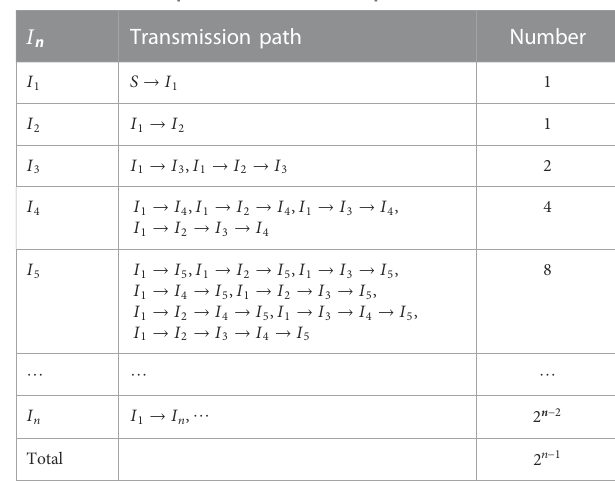
TABLE 1 Simulation parameter values for chapter